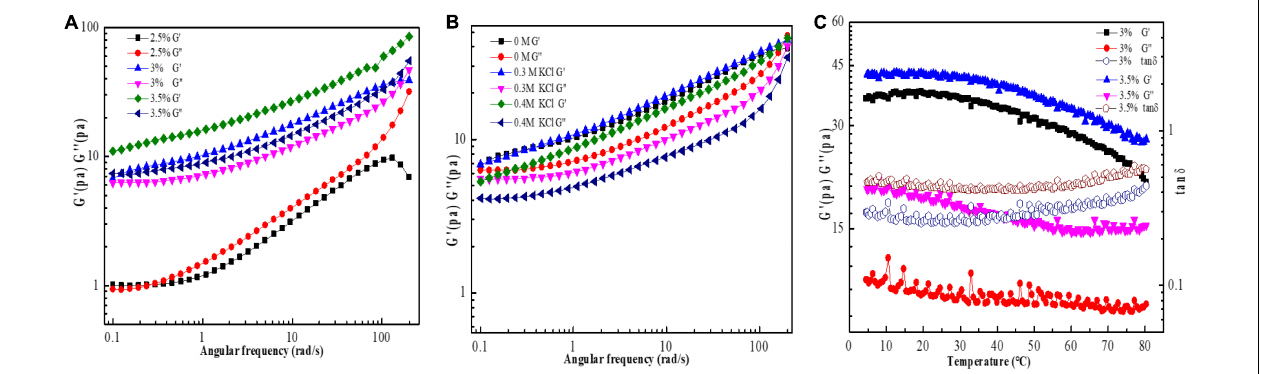
FIGURE 7 | Dynamic frequency sweep of EPS-3 solutions at different concentrations (A) ; Influence of K + on G’ (storage modulus) and G” (loss modulus) of 3% EPS-F2 solution (B) ; Temperature dependence of G’ and G” of 3% EPS-F2 solution (C) .